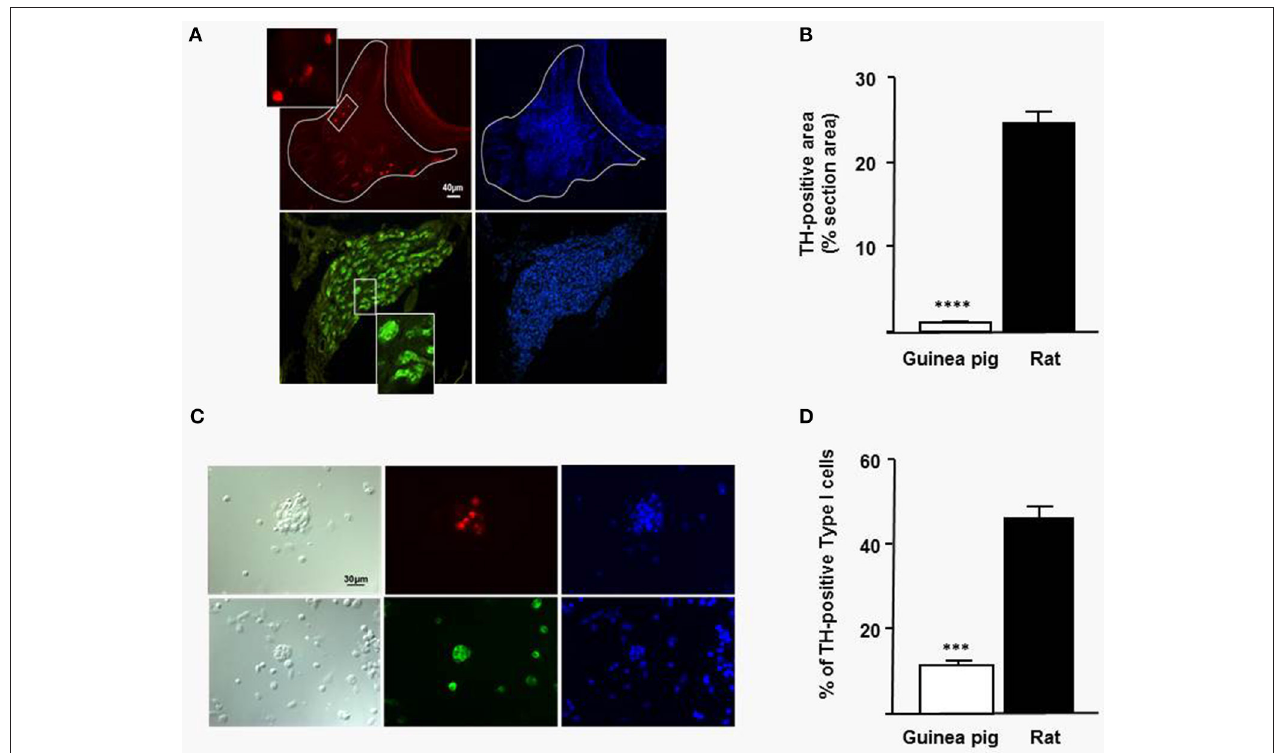
FIGURE 2 | (A) Immunostaining for TH of central CB sections. The upper row shows a CB from guinea pig immunostaining for TH (red) and the same section immunostaining for DAPI (blue) to show cellularity. In the lower row the same sequence for rat CB (TH, green). The box shows an extension of the selected area the same scale bar for both species in (A,C) . (B) Percentage of TH-positive area obtained from CB sections from guinea pigs and rats. Data are mean ± SEM of 64 sections from 4 guinea pig CB and 150 sections from 4 rat CB ( n = 4; **** p < 0.0001). (C) Left part shows dissociated cells from CB culture (bright field); center, immunostaining for TH and right, cell nuclei stained with DAPI. Upper row from guinea pig CB and lower row from rat CB dissociated cell culture. In (D) it is represented the percentage of TH-positive cells from 604 nuclei from guinea pig CB dissociated cells and 770 nuclei from rat CB dissociated cells, in both cases obtained from four guinea pigs and rats. Data are mean ± SEM ( n = 4; *** p < 0.001).